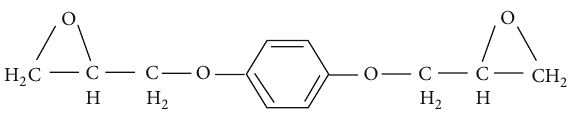
Figure 1: Chemical formula of the epoxy resin 1,3-bis(2,3-epoxy- propoxy)-benzene [41].